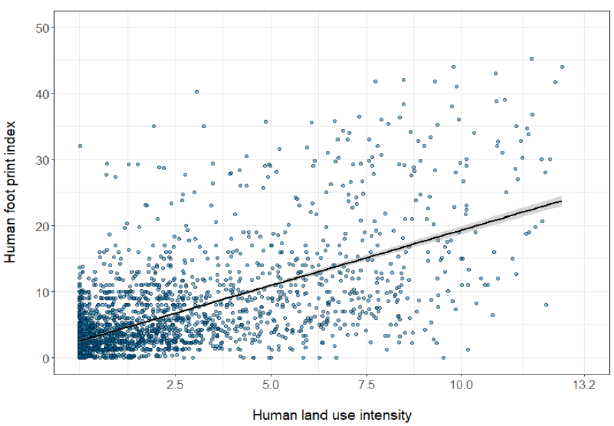
Figure 7. The relationship between The Human Footprint Index and the LUI for a sample of 3000 randomly selected points throughout Norway. The black line represents a regression line, while the shaded areas represent uncertainty in the linear fit of the trend line with a 95% confidence level.